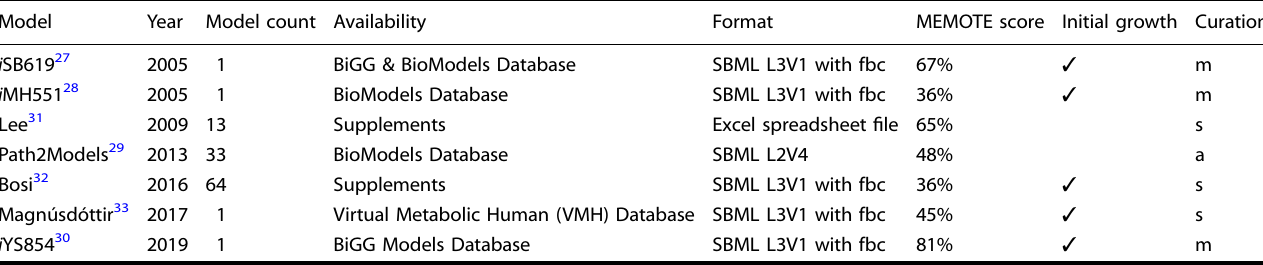
Table 1. Overview over the available S. aureus